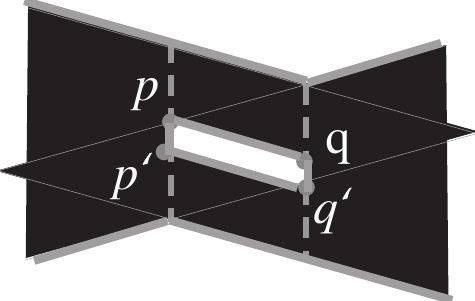
Figure 5. The cross section of the middle part of S f . At each positive t the following segments are identified: ( p (cid:48) q (cid:48) ) = l (cid:48) , ( pq ) = l 2 , ( p (cid:48) p ) = ( q (cid:48) q ) . 2 The last step in building S f is gluing together K L K L (cid:48) pq and 2 , p (cid:48) q (cid:48) and 2